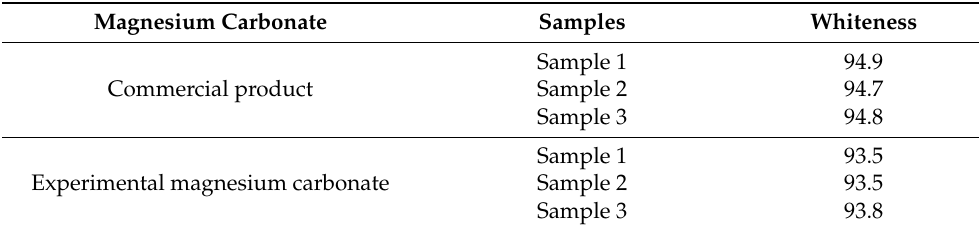
Table 3. Whiteness of commercial product and experimental magnesium carbonate.